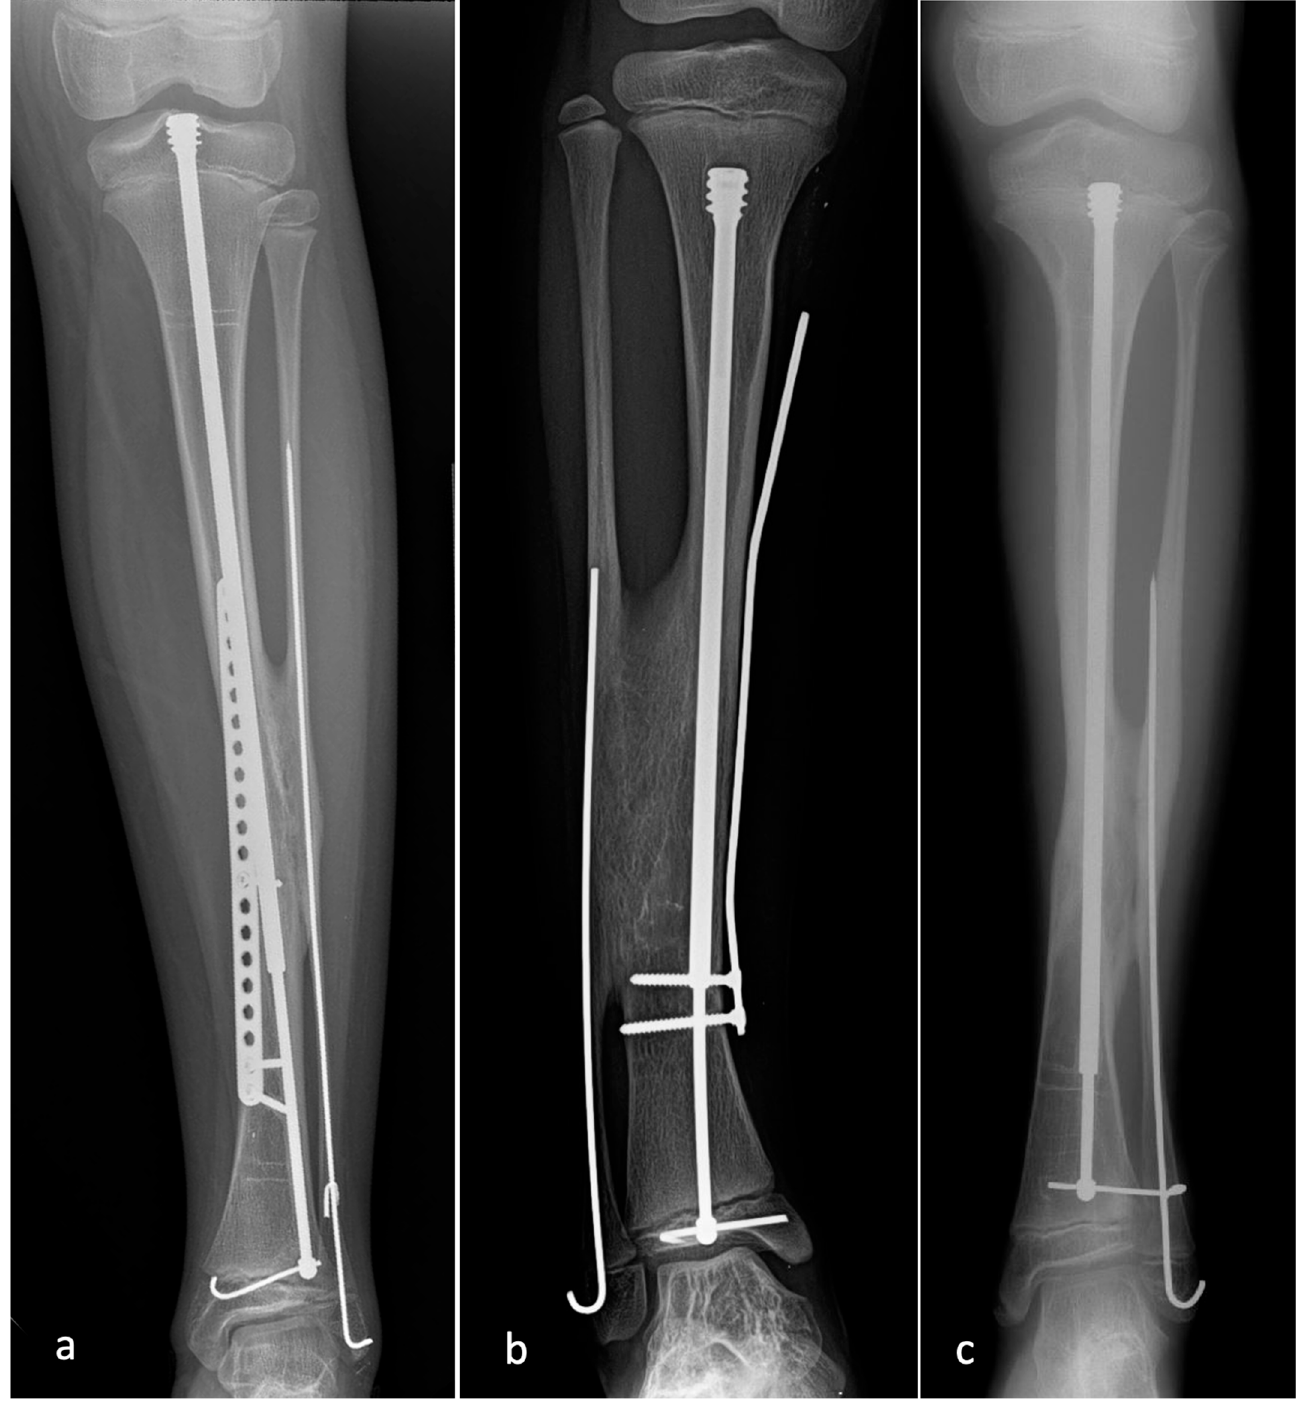
Figure 3. Radiographs demonstrating the various forms of FD rod migration: ( a ) the rod has pulled out of the distal epiphysis; ( b ) the rod has pulled out of the proximal epiphysis; ( c ) the rod has pulled out of both proximal and distal epiphyses. Note the reconstitution of the physis despite the breach by the FD rod.